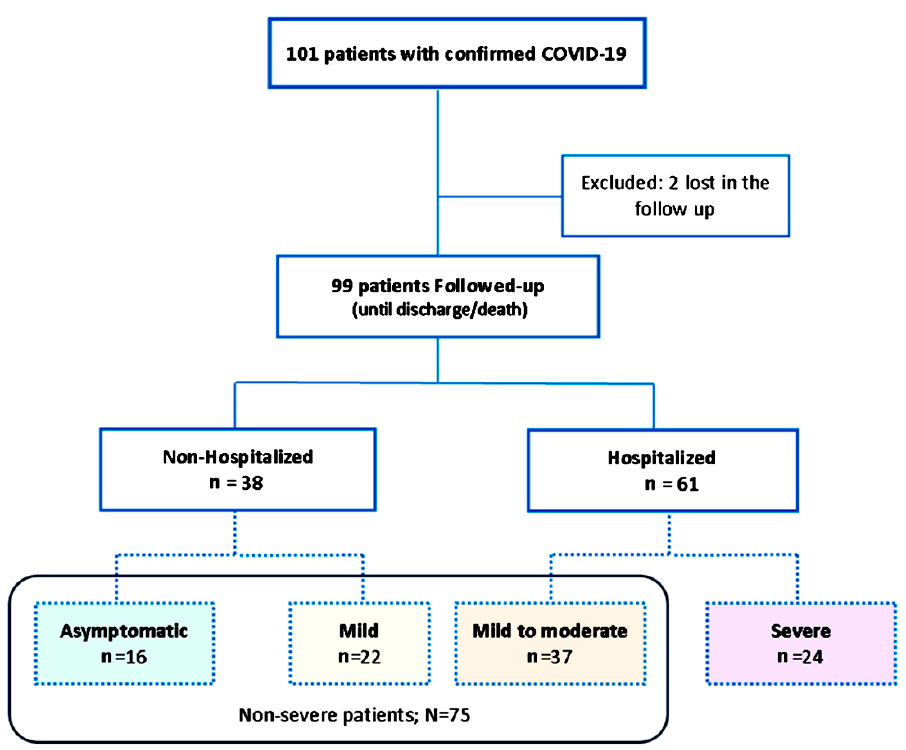
Figure 4. Algorithm of patient classifications according to disease severity.